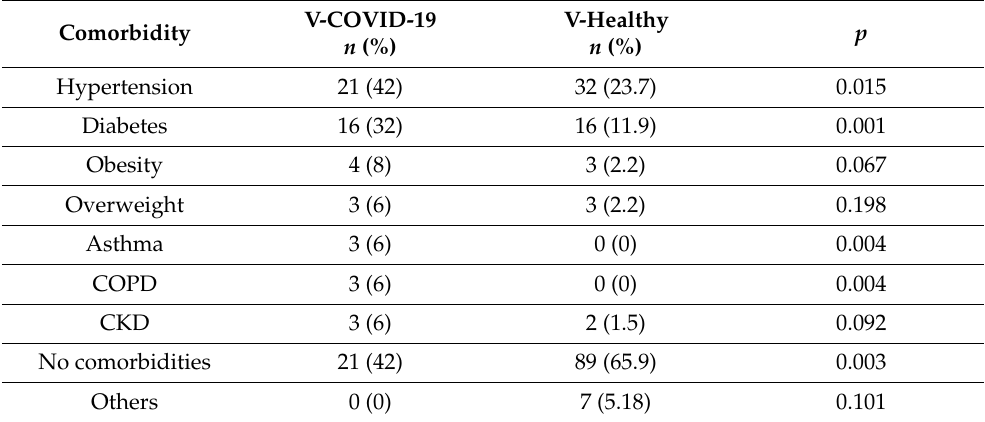
Table 5. Comorbidities in the studied population.